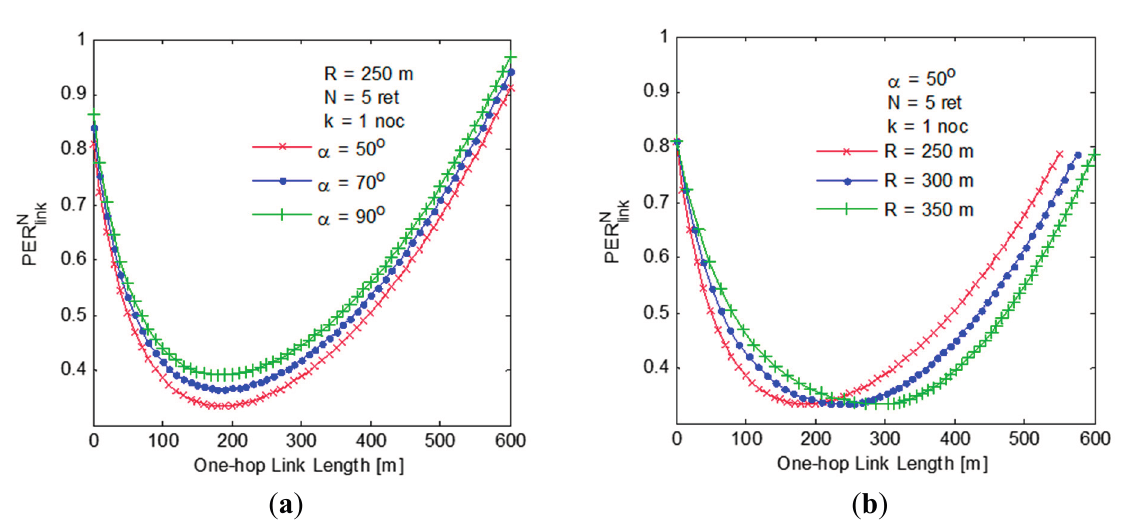
(cid:3015)(cid:3009)(cid:3023)